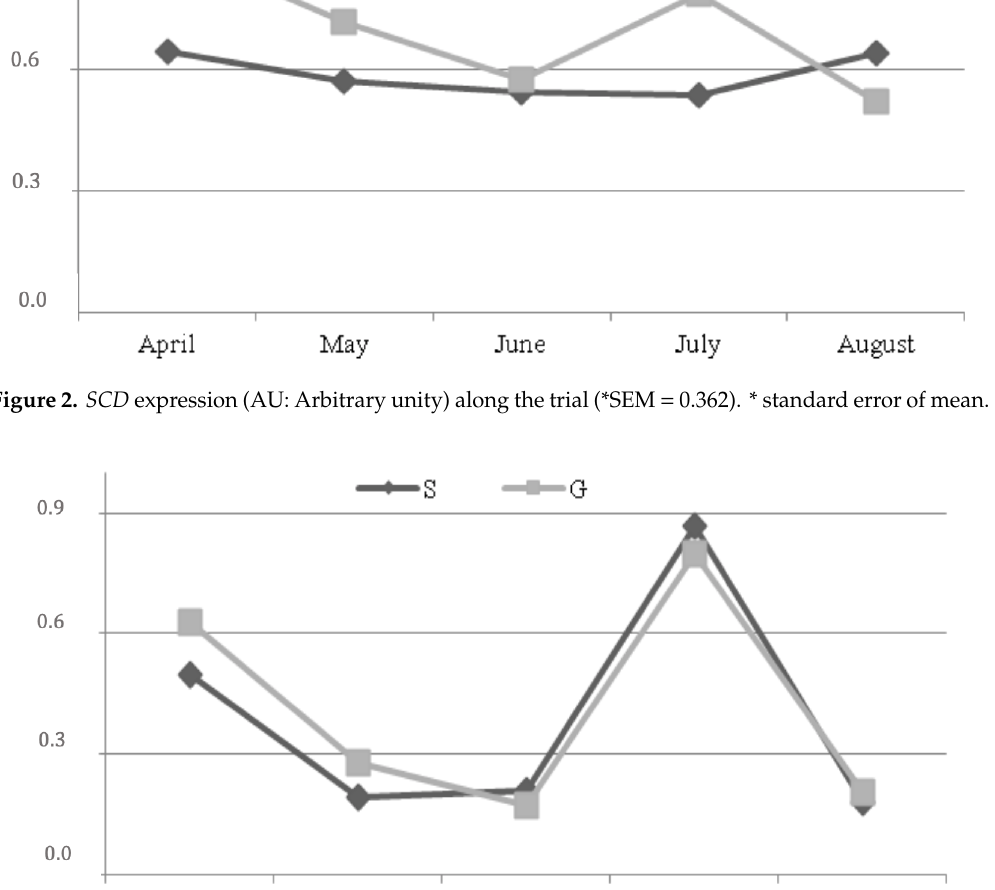
Figure 3. Expression of miRNA 103 (AU: Arbitrary unit) along the trial (*SEM = 0.121). * standard error of mean.